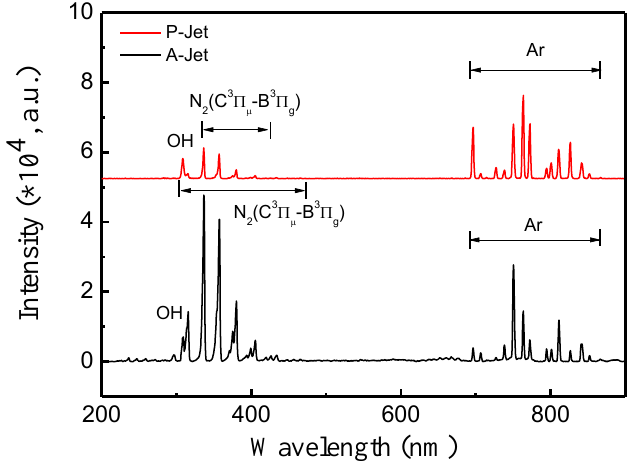
Figure 10. Optical emission spectra of the A-Jet and P-Jet near the liquid surface.